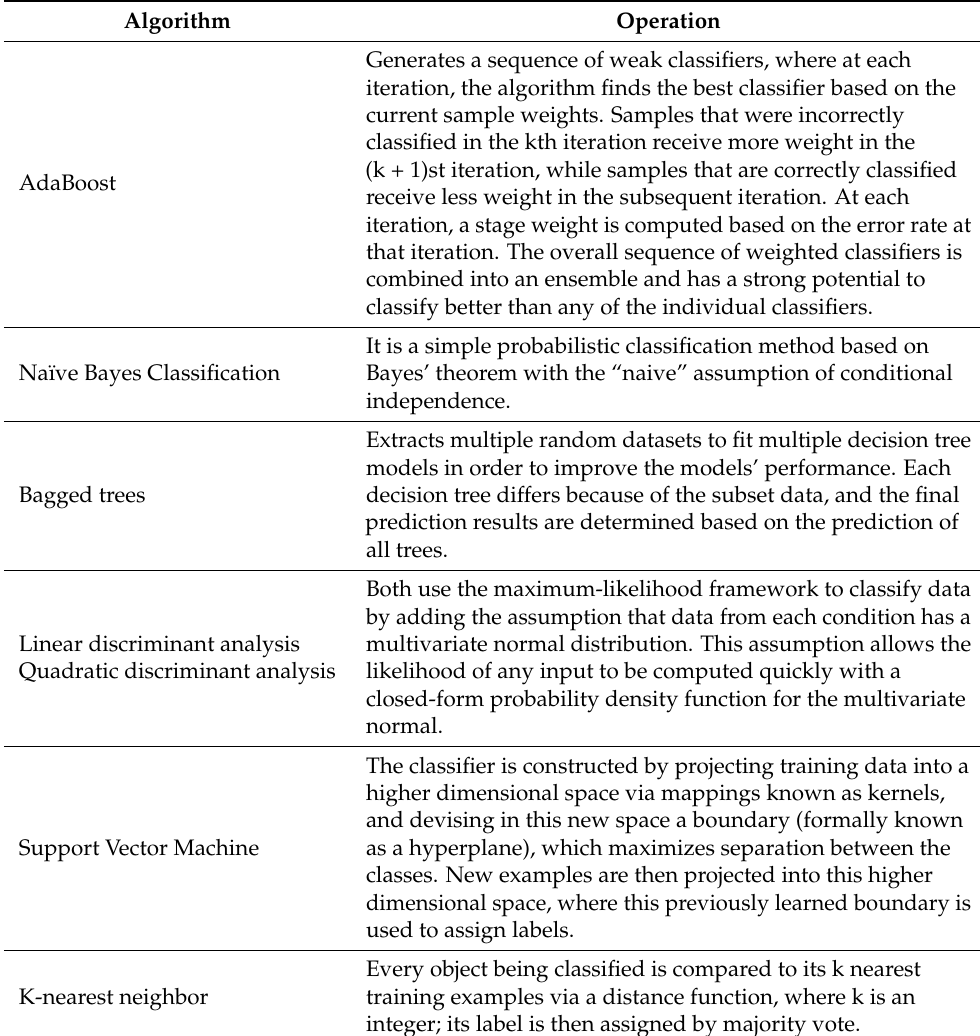
Table 2. Operation of algorithms used in the main machine learning studies in cardiovascular disease